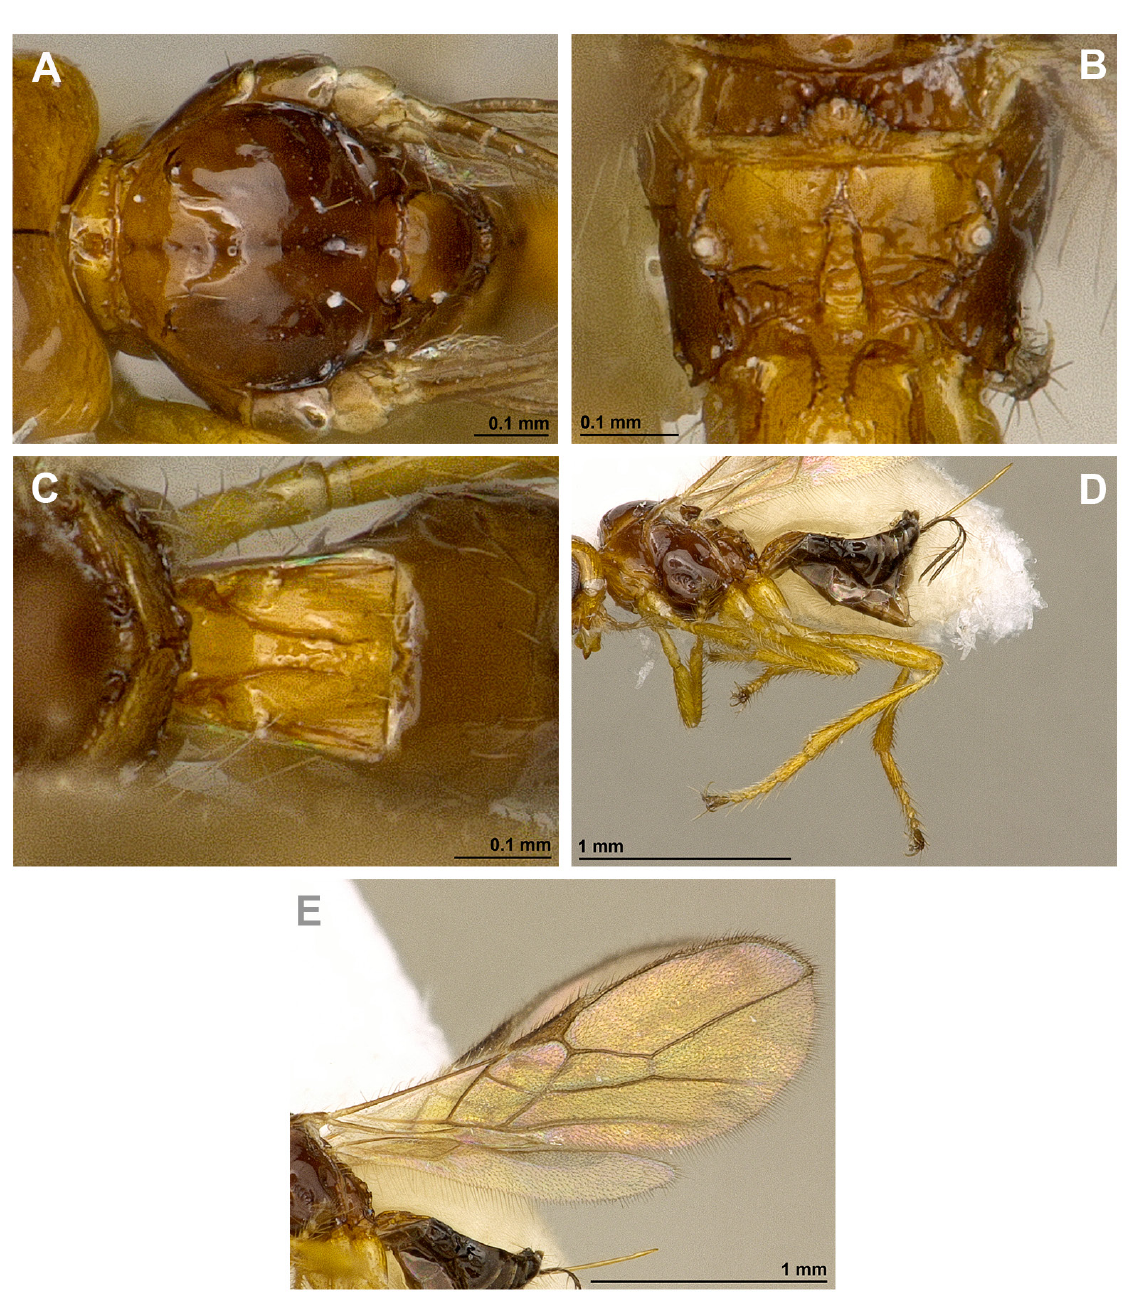
Fig. 77. Asobara zaprionae van Achterberg, sp. nov., ♀, holotype (RMNH). A . Mesoscutum, dorsal view. B . Propodeum. C . First metasomal tergite, dorsal view. D . Hind leg, metasoma and ovipositor, lateral view. E . Fore and hind